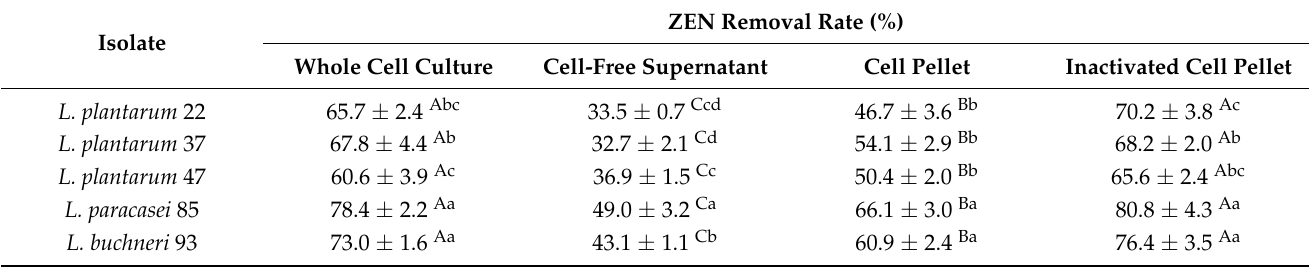
Table 2. ZEN removal abilities of whole cell culture, cell-free supernatant, cell pellet, and inactivated cell pellets of pickle-derived LAB.